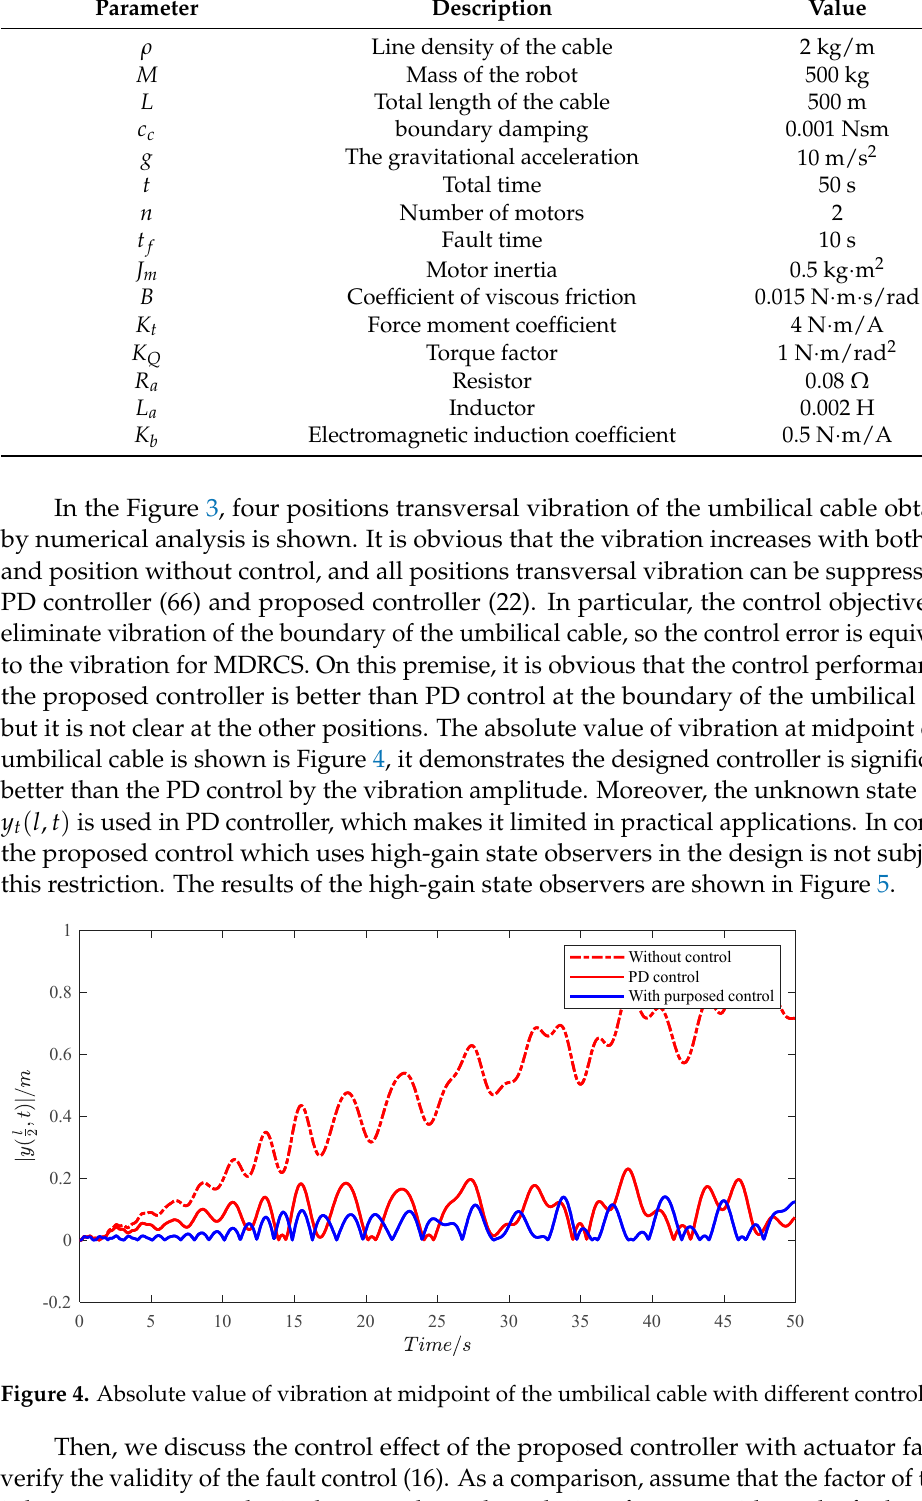
Figure 5. The actual values and observed values of the system state values. Then, we discuss the control effect of the proposed controller with actuator fault to verify the validity of the fault control (16). As a comparison, assume that the factor of thrust is known, so we may obtain the control angular velocity of motors without the fault control. The responses of MDRCS in the following four cases are needed. 1.